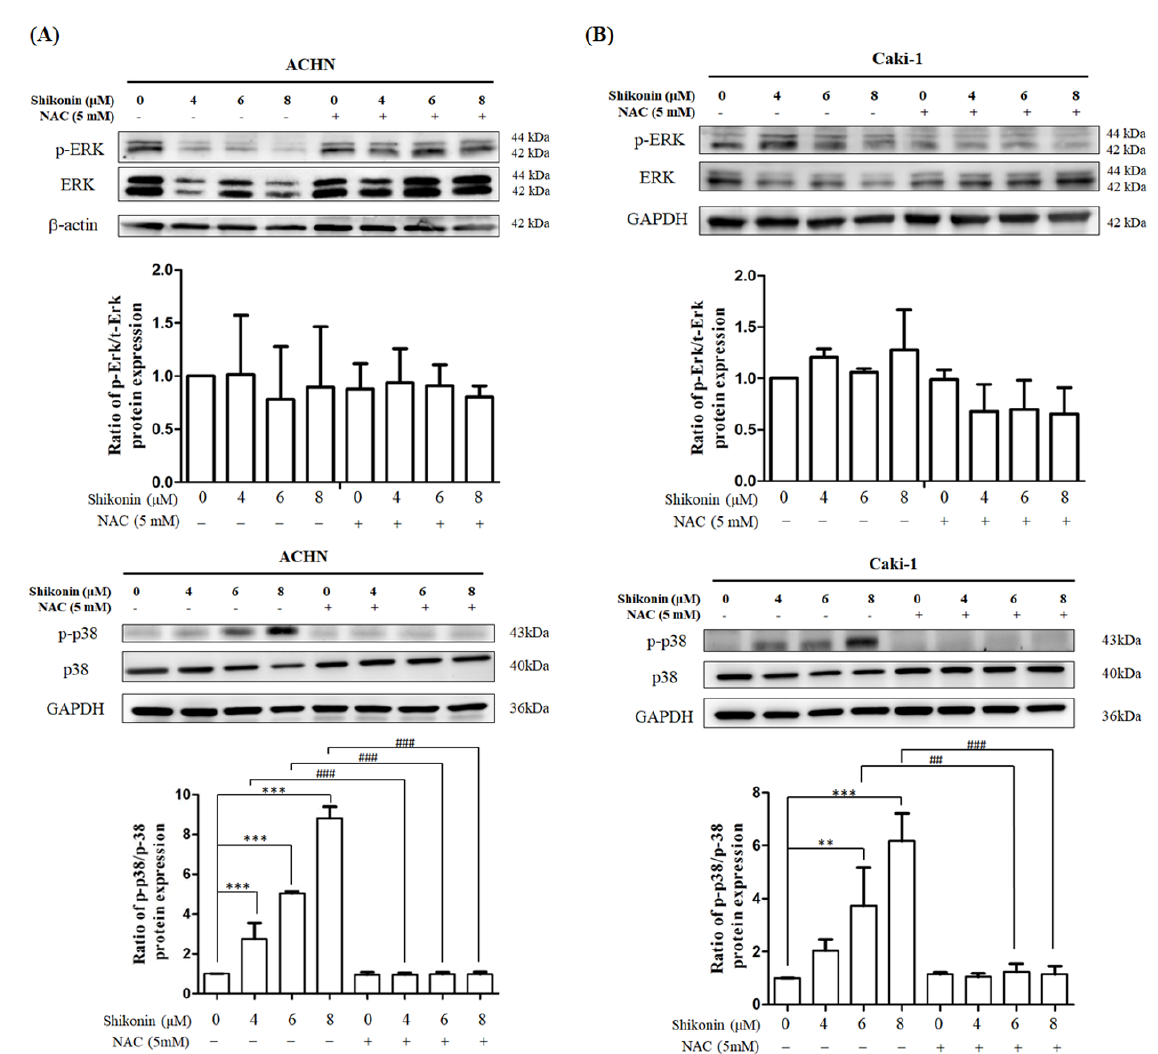
Figure 8. Shikonin promoted p38 activity but not ERK activity. ( A ) ACHN and ( B ) Caki-1 cells were treated with 0, 4, 6, and 8 μ M shikonin with or without NAC pretreatment. The cell lysates were analyzed by Western blot using ERK or p38 antibodies. Data represent means ± standard deviation from at least three independent experiences. ** p < 0.01 and *** p < 0.001 compared with the control group. ## p < 0.01 and ### p < 0.001 compared with the NAC pretreated group. GAPDH was used as the internal control.